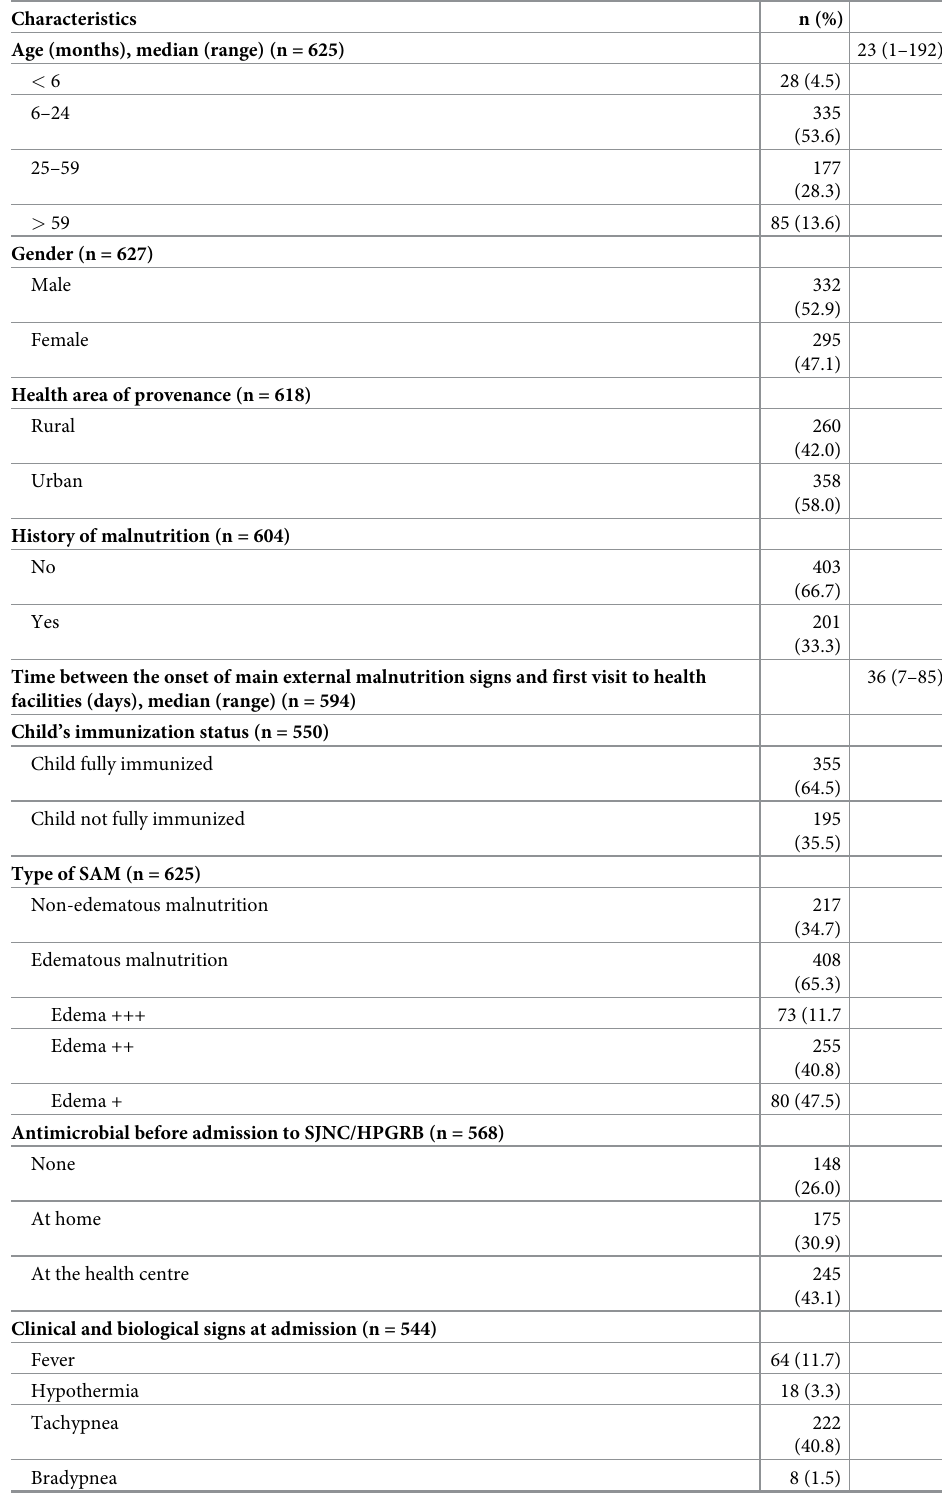
Table 1. Baseline characteristics of the study